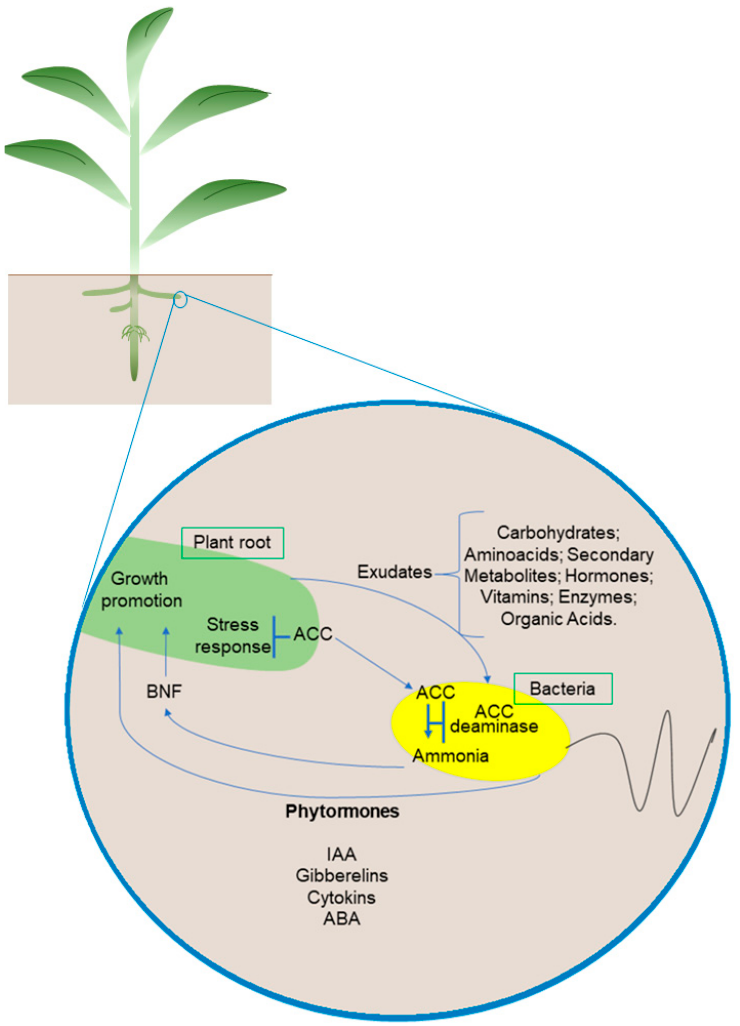
Figure 2. Microorganism–plant interaction. Plant roots and bacterial cells synthesize metabolites as substrates and signaling molecules. Microorganisms used as biofertilizers promote plant growth through biological nitrogen fixation, nutrient solubilization (phosphate and iron), and the production of hormones and other compounds. A dashed line indicates a positive relationship between plants and bacteria. Abbreviations: ACC, 1-aminocyclopropane-1-carboxylate; ACC deaminase, 1-aminocyclopropane-1 carboxylate deaminase; BNF, biological nitrogen fixation. Organisms and cells are not to scale.